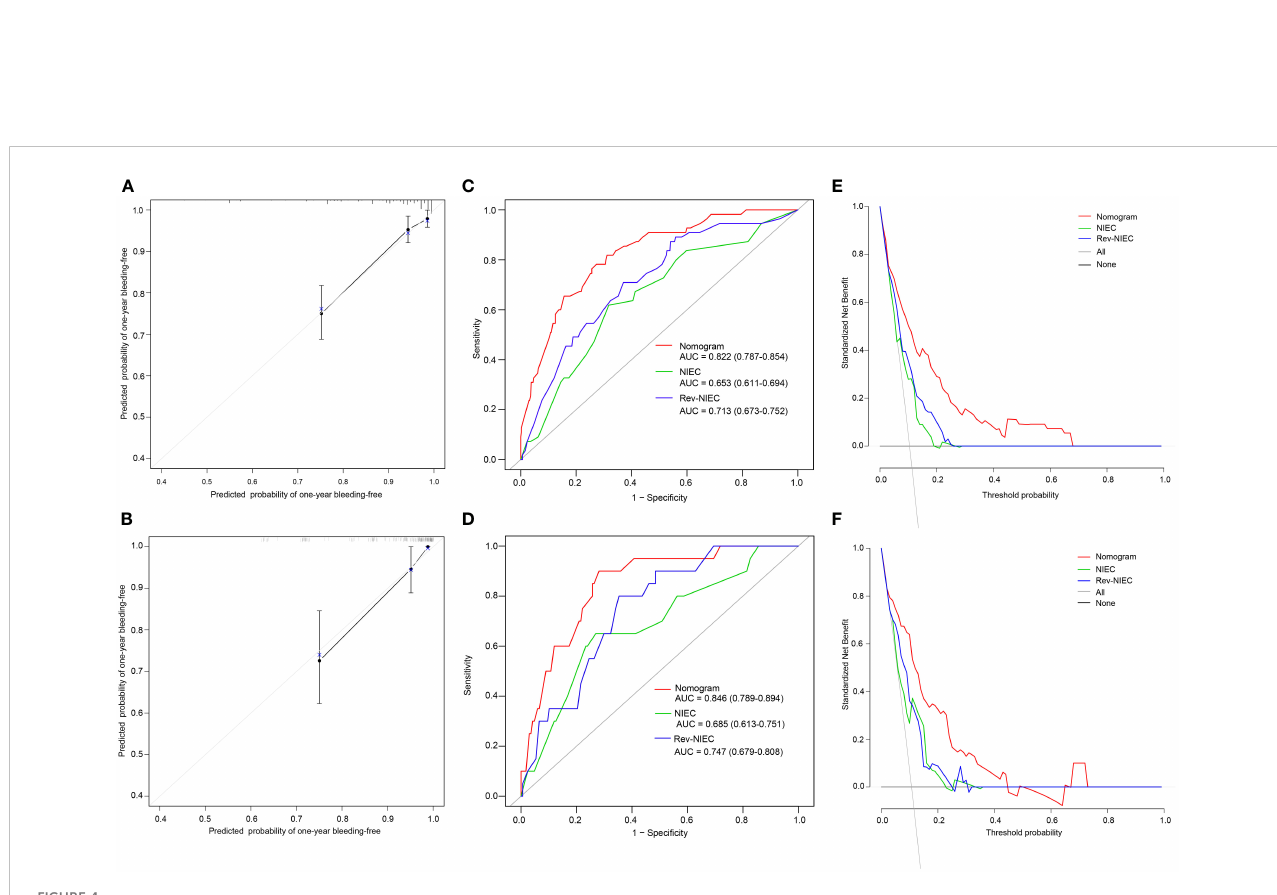
FIGURE 4 Calibration plots, ROC curves, and DCA curves for predicting VH in HBV-related cirrhotic patients with GEVs. The calibration plots of the nomogram for VH in the derivation (A) and validation cohorts (B) , in which the predicted probability of VH was compared with the actual bleeding probability. The ROC curves of the nomogram, NIEC index, and Rev-NIEC index in the derivation (C) and validation cohorts (D) . The DCA curves in the derivation (E) and validation cohorts (F) show that the net bene fi t of the nomogram is greater than the net bene fi t of the NIEC and Rev-NIEC indexes. Abbreviations: AUC, areas under the receiver operating characteristic curve; NIEC, North Italian Endoscopic index; Rev-NIEC, revised NIEC index; ROC, receiver operating characteristic; DCA, decision curve analysis; VH, variceal hemorrhage; HBV, hepatitis B virus; GEV, gastroesophageal varice.